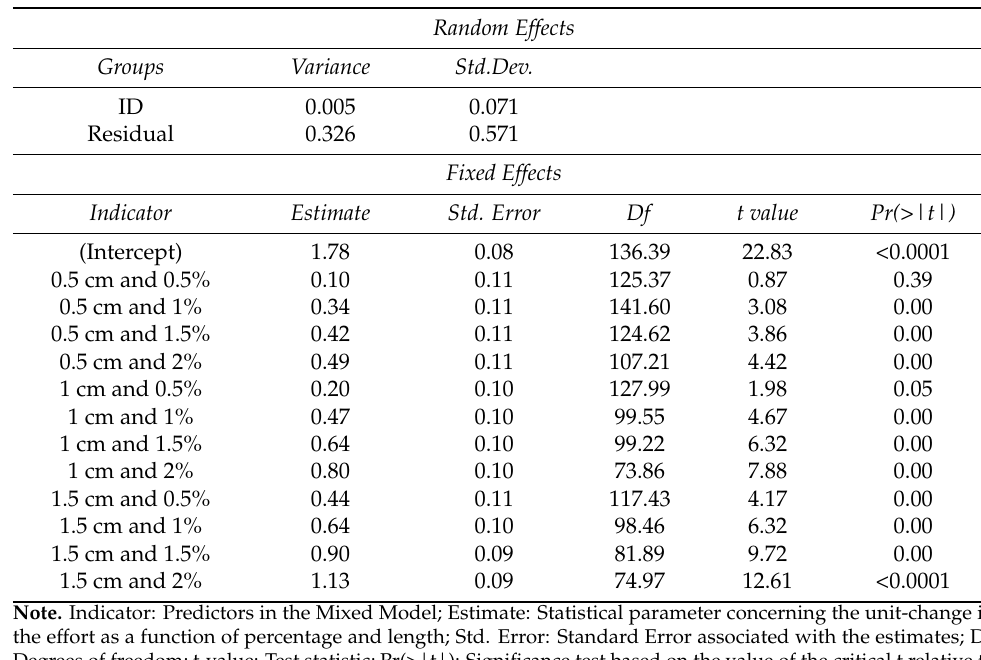
Table 5. Linear mixed model examining the effect of condition on the log10 transformed effort. The model used ID as a random effect with control as a reference category. The estimation procedure was computed using REML.